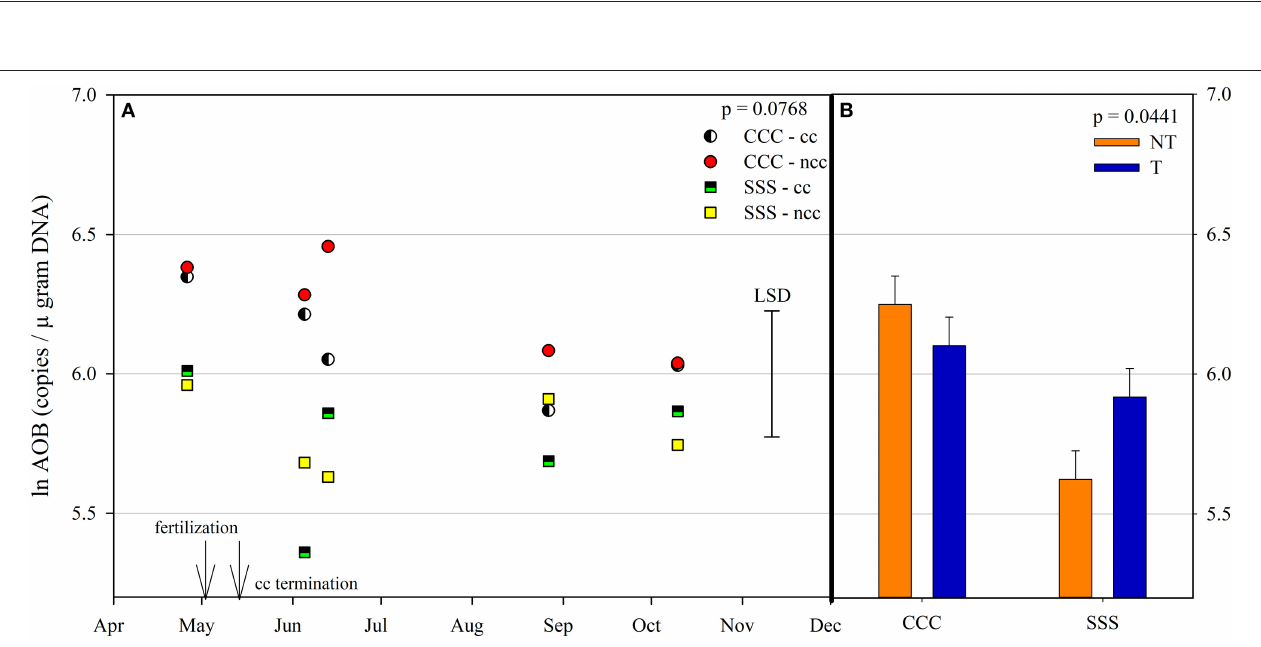
FIGURE 5 | (A) Mean lognormal transformed ammonia-oxidizing bacteria (AOB) values (copies µ gram DNA − 1 ) throughout the 2019 growing season separated by crop rotation [CCC, continuous corn (circles); SSS, continuous soybean (squares)] and cover crop [CC, cover crop (partial fill); NCC, no cover crop (solid fill)]. Significant differences in treatment means can be interpreted by the Least Square Differences (LSD) error bar to the right of the figure. Mean values that fall beyond the distance of the LSD are significant at α = 0.10. (B) mean lognormal transformed ammonia-oxidizing bacteria (AOB) values (copies µ gram DNA − 1 ) separated by tillage [NT, no-till (orange); T, chisel tillage (blue)] and crop rotation [CCC, continuous corn; SSS, continuous soybean]. Error bars above each main bar represent standard errors of the mean PC scores. Differences are significant at α = 0.10.